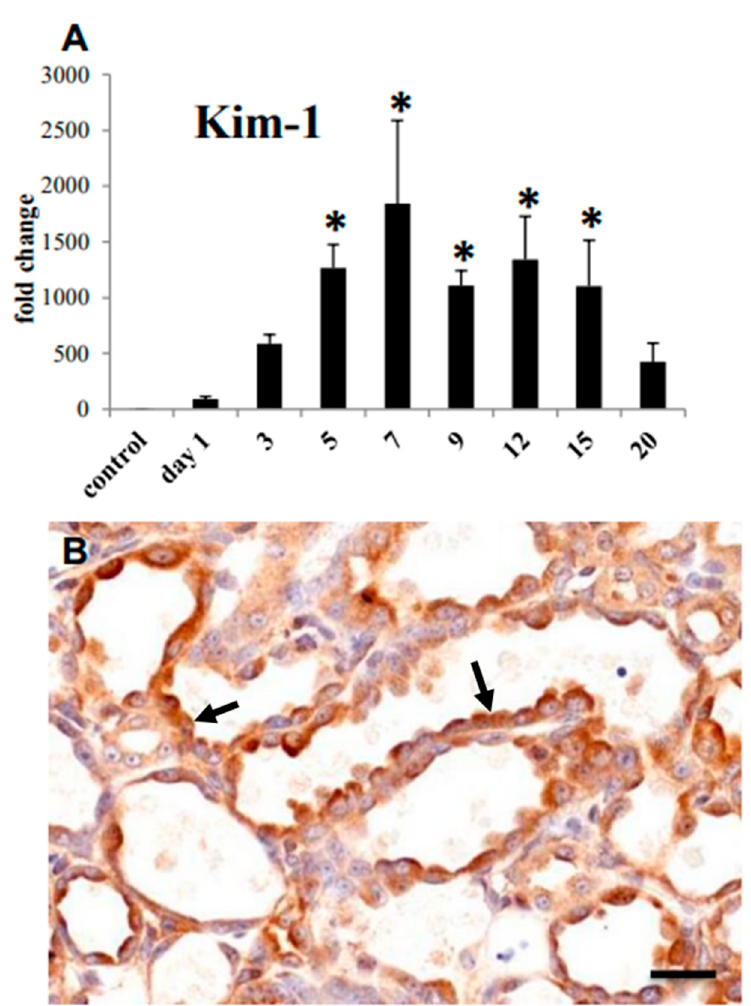
Figure 2. CDDP-induced renal lesions in rats. ( A ) mRNA expression of kidney injury molecule-1 (KIM-1) in the control and CDDP-injected rats on days 1 to 20; Dunnett’s test, *, significantly different from controls at p < 0.05. ( B ) Immunohistochemistry for KIM-1; arrows indicated immune-positive regenerating epithelial cells of the affected tubules on day 9. Bar = 50 µm.